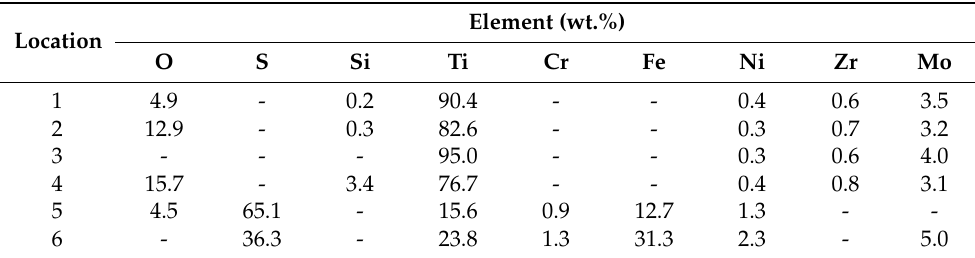
Table 12. Elemental analysis from locations in Figure 14.